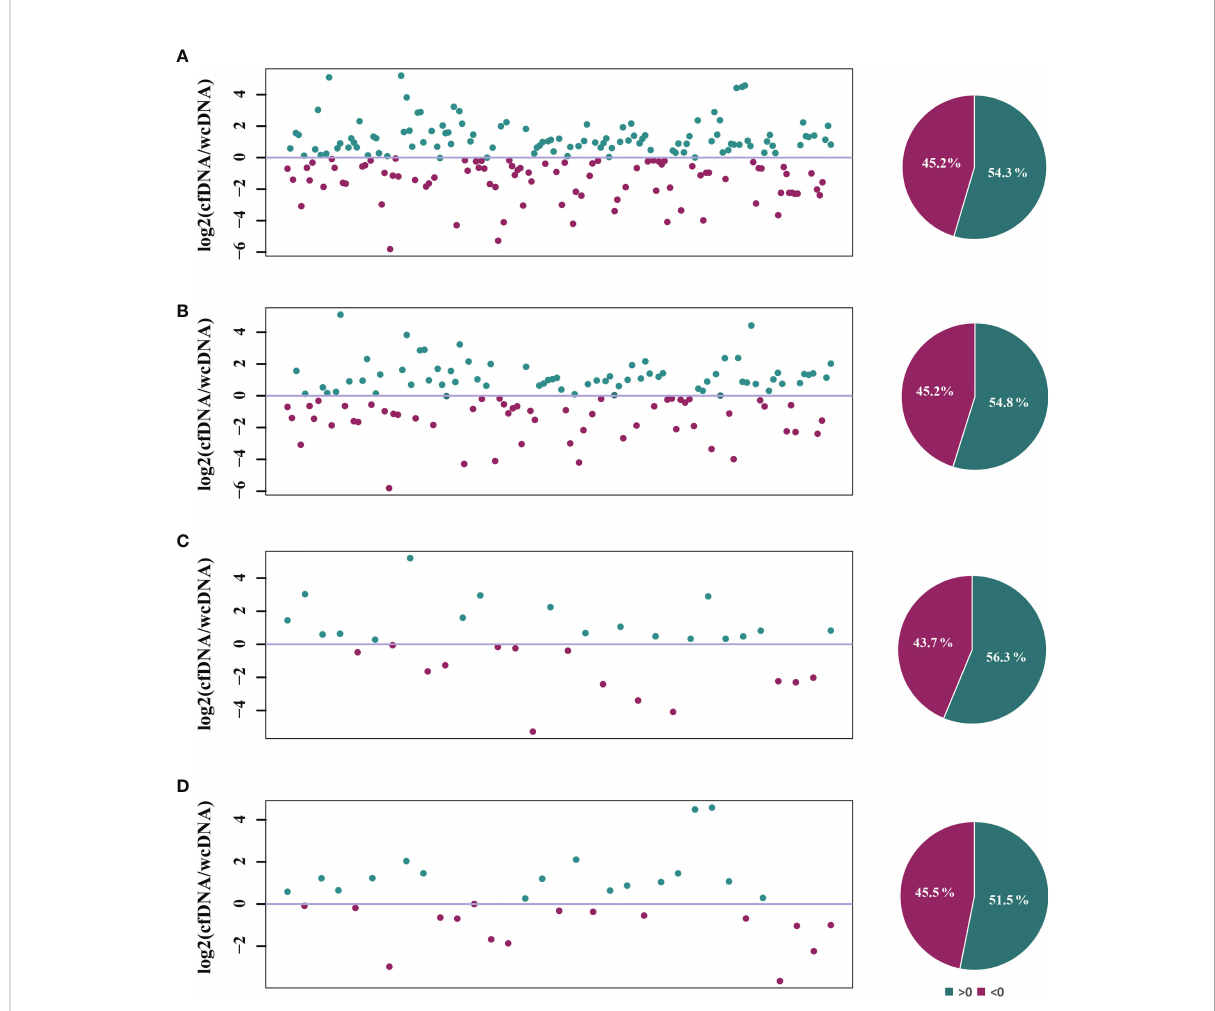
FIGURE 3 Comparison of the RPM detected by mNGS of both cfDNA and wcDNA. (A) , All microbes detected by mNGS. (B) , Bacteria detected by mNGS. (C) , Fungi detected by mNGS. (D) , Viruses detected by mNGS. The number of microbes and base-2 logarithm of reads per million (RPM) detected by mNGS of cfDNA divided by that detected by mNGS of wcDNA for the same microbes were used to draw scatter plot, and the dots of >0 represented that the numbers of RPM detected by mNGS of cfDNA was higher than that detected by mNGS of wcDNA for the microbes. The microbes only detected by mNGS of cfDNA or wcDNA were summarized in Table